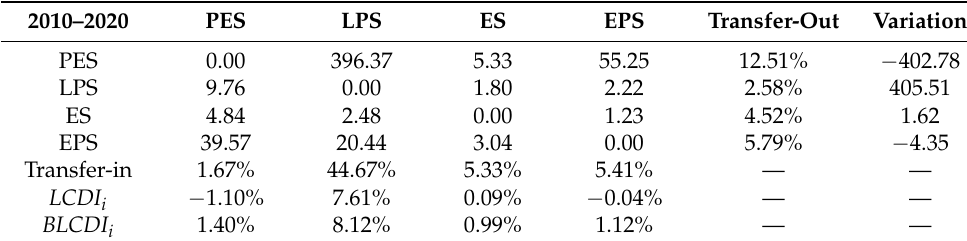
Figure 5. Spatial – temporal distribution characteristics of the LUCs from 2000 to 2020 .